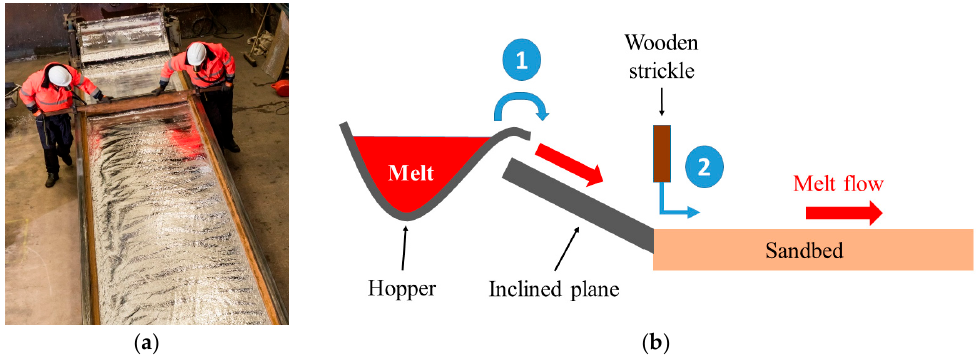
Figure 1. ( a ) Snapshot and ( b ) schematic representation of the lead sheet casting process.